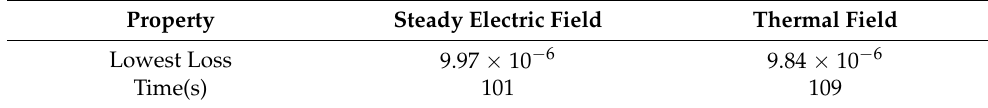
Table 1. The lowest loss values and the time consumed in each training.